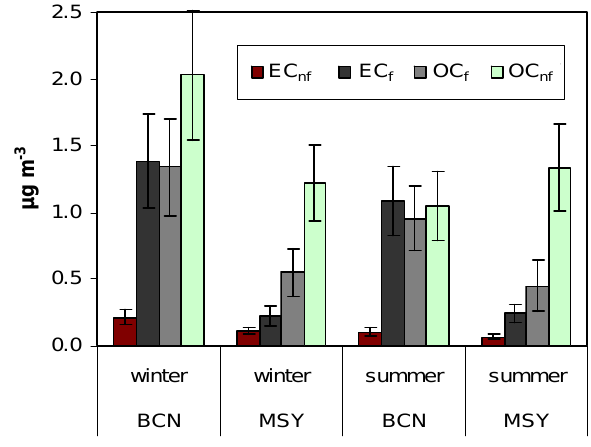
Figure 2 Fig. 2. Average absolute concentrations of the fossil (f) and non- fossil (nf) fractions of EC and OC (µgm − 3